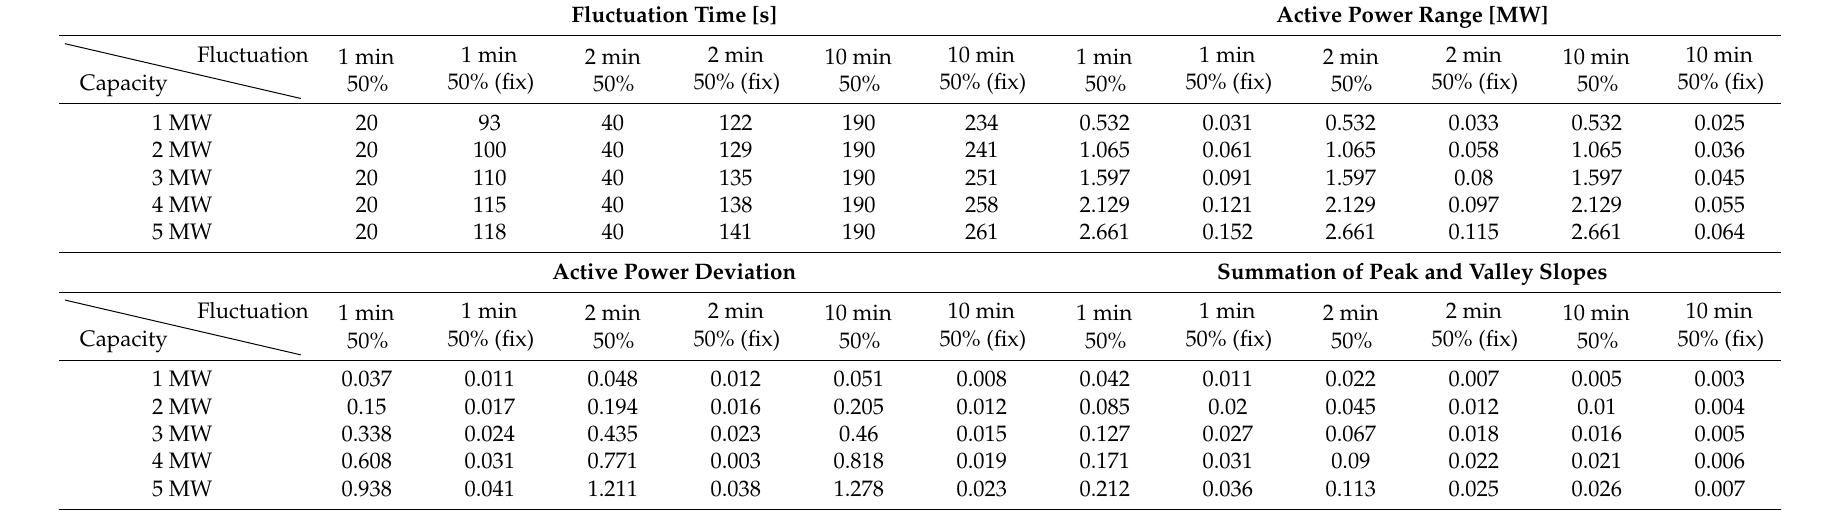
Table 5. Assessment results for a PV-HT hybrid system with 50% solar radiation